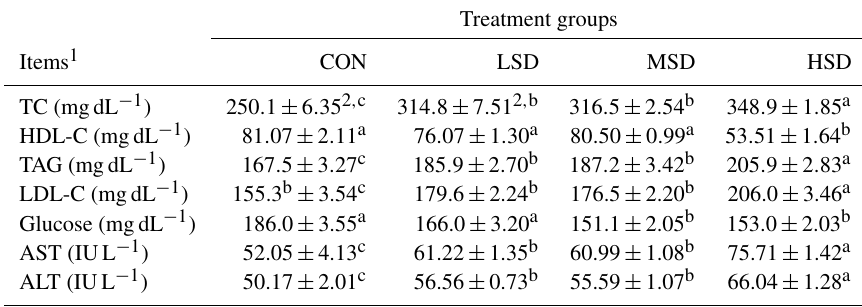
Table 1. Effect of different stocking densities on the blood lipid profiles and levels of glucose, AST, and ALT in meat ducks exposed to heat stress.